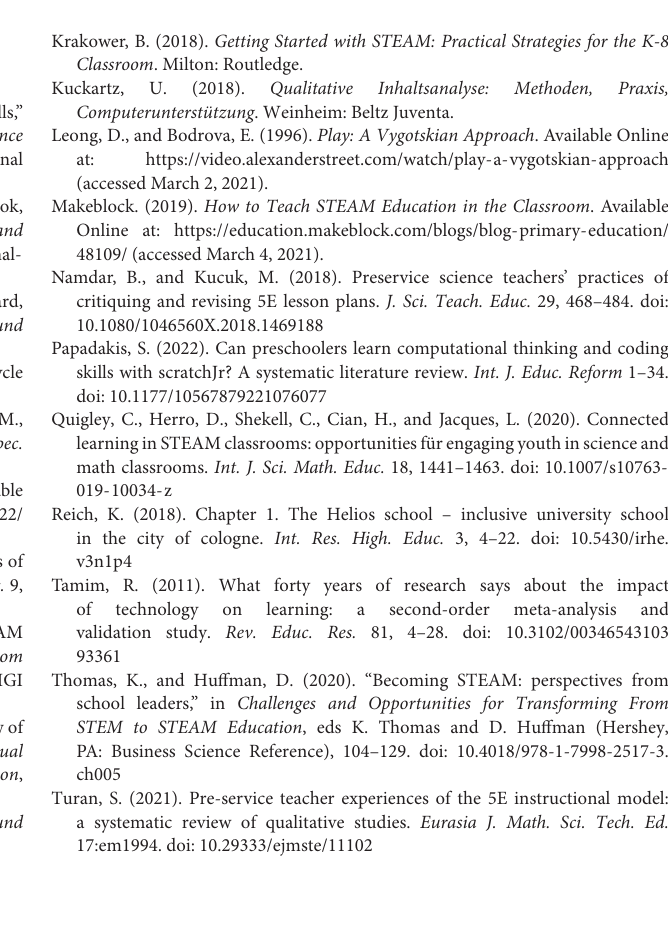
Supplementary Figure 1 | Screenshot from the video regarding SDGs 2 zero hunger and 6 clean water and sanitation. Supplementary Figure 2 | Screenshot from the video regarding SDGs 3 good health and wellbeing and 11 sustainable cities and communities. Supplementary Figure 3 | 7th grade students use the modular neuron-set to build their own prototype of a remote-controlled robot that carries a water pump. In later versions they included a water tank as well as a measuring device for soil moisture to determine when the pump should be activated to water certain spots. Supplementary Figure 4 | Students elaborate on how to apply significant payload to a small drone while maintaining stable